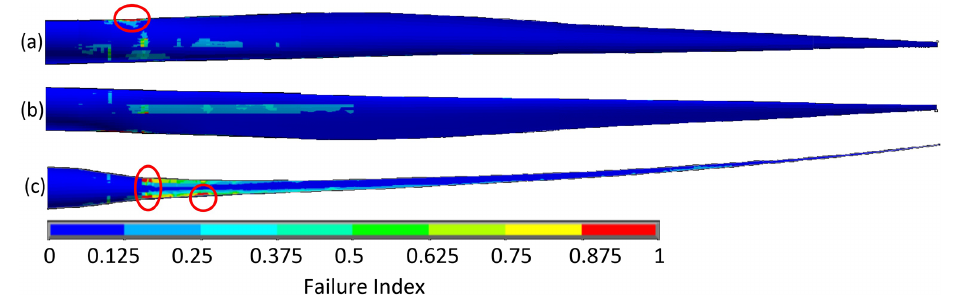
Figure 9. Tsai–Wu failure index for the optimized BAR-DRC design under critical loading, shown from the (a) pressure side, (b) suction side, and (c) cut-away view, showing the leading shear web. Vulnerable areas circled in